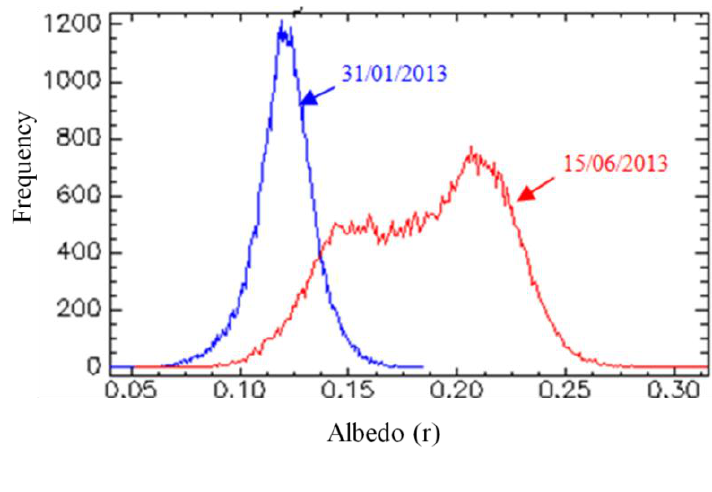
Figure 5. Comparison between the spatial distribution (absolute frequency) of surface albedo estimated by SPOT4 (HRVIR1) in winter and summer (Faregh